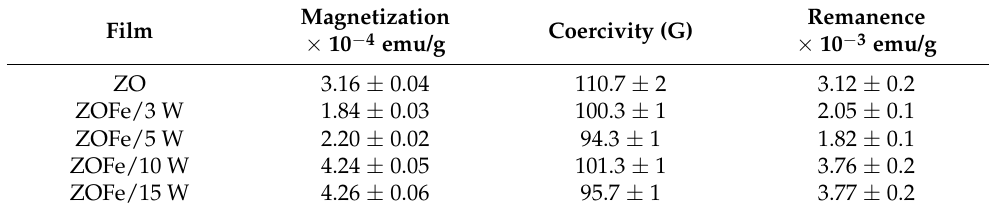
Table 7. Magnetization, coercivity and remanence values of undoped and Fe doped ZO thin films. Magnetization Coercivity Film × 10 − 4 emu/g